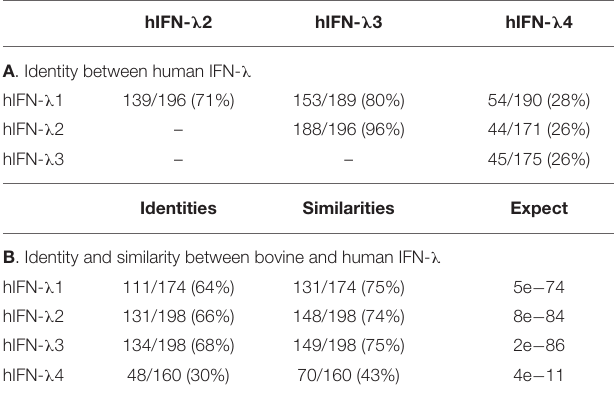
TABLE 1 | Analysis of bovine and human IFN- λ sequences.